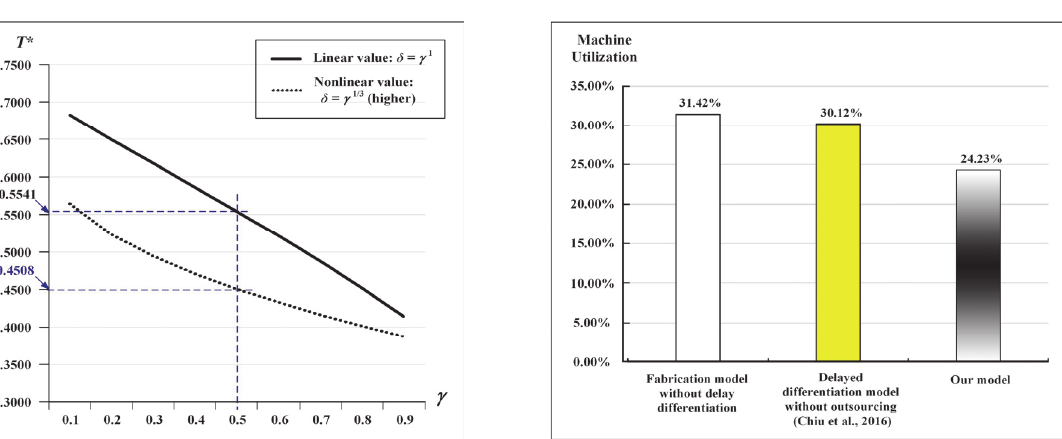
Fig. 16. Comparison of the utilization of our model with that in the similar